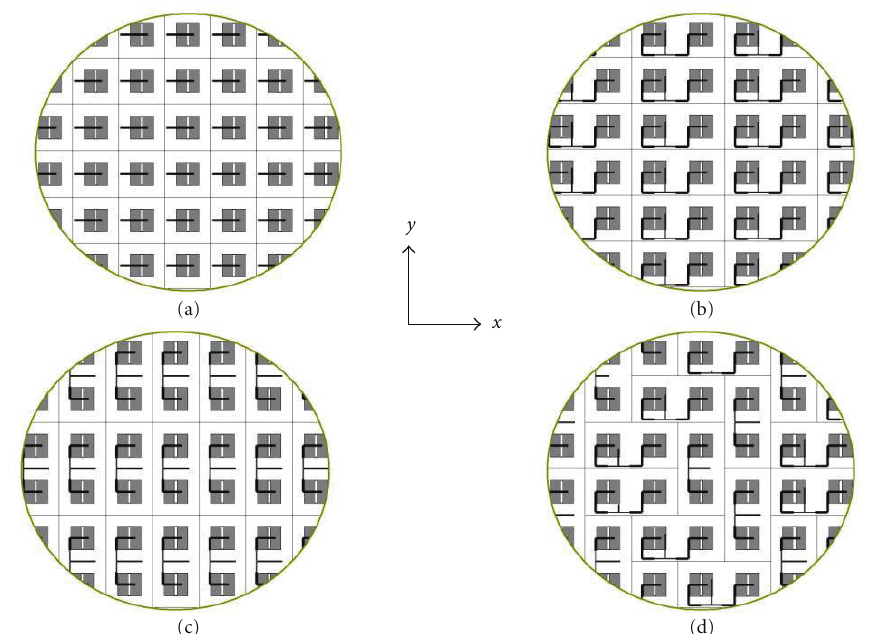
Figure 6: Detailed view of di ff erent lattices for a reflectarray based on aperture-coupled elements. (a) Single elements. (b) Gathered elements along the x -axis. (c) Gathered elements along the y -axis. (d) Irregular